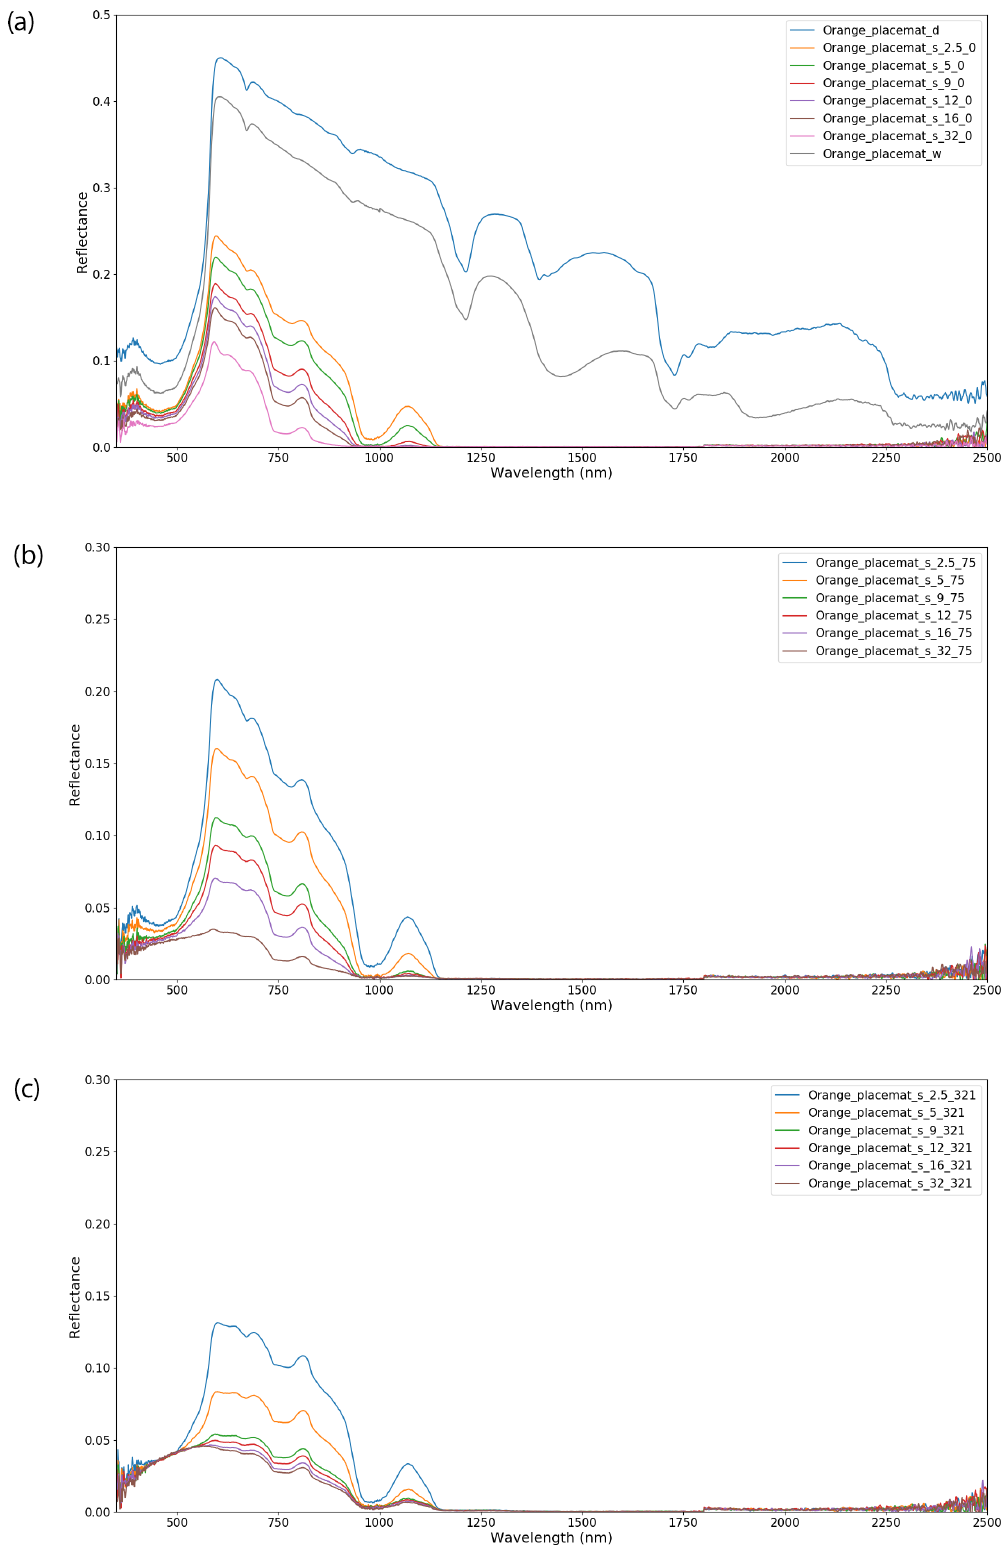
Figure 6. Spectral reflectance of the orange place mat submerged in (a) clear water, (b) water with a TSM concentration of 75mgL − 1 and (c) water with a TSM concentration of 321mgL − 1